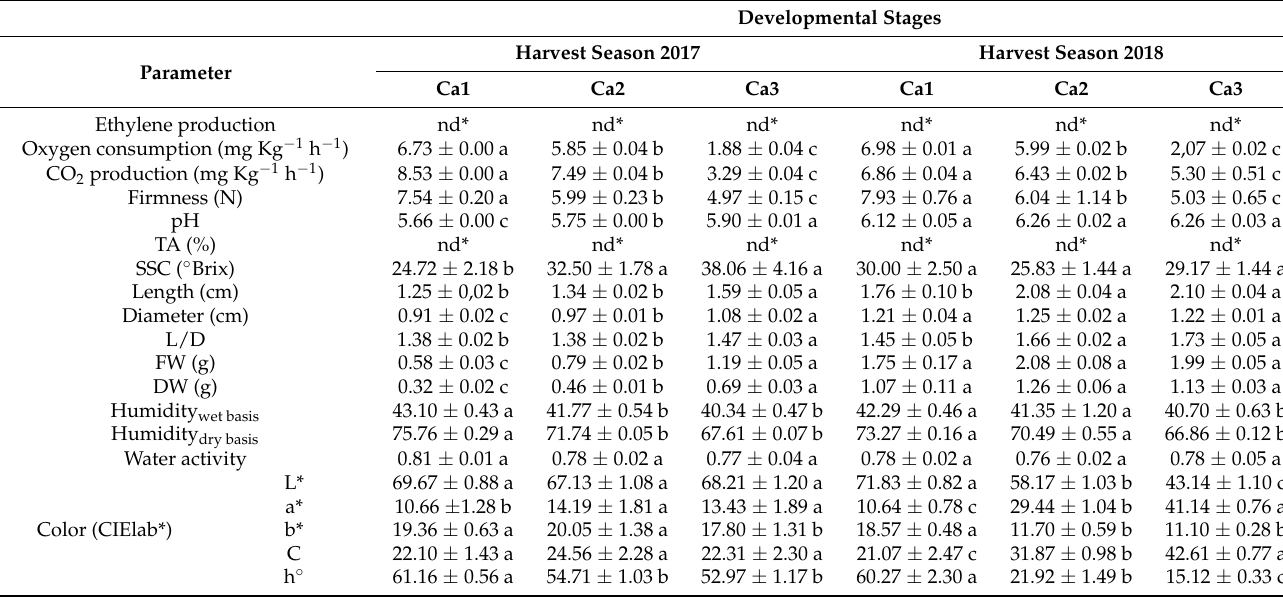
Data correspond to the mean ± SE. Different letters point to significant differences between developmental stages in each harvest season ( p ≤ 0.05). SSC, soluble solids content; TA, titratable acidity; FW, fresh weight; L/D, length and diameter ratio; DW, dry weight. Statistical analysis: One-Way ANOVA. Tukey ( p < 0.05). nd*, not